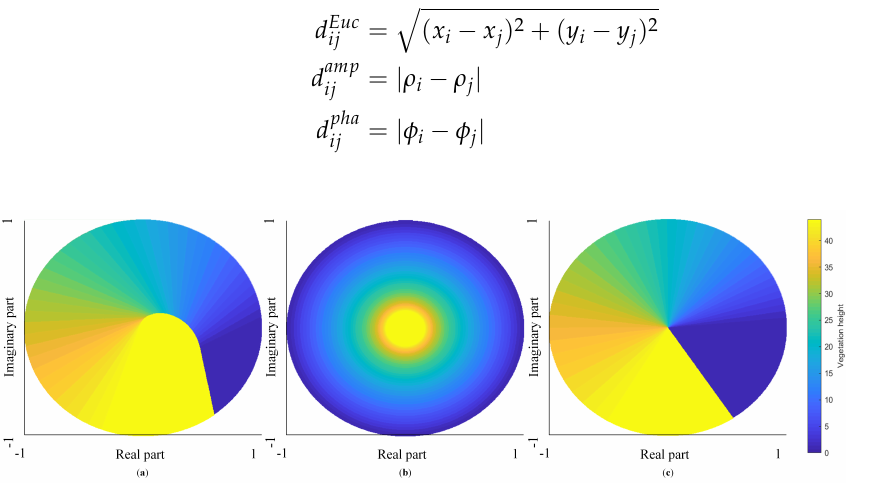
Figure 6. The mapping of vegetation height and coherence in the CUC plane using least distance criterion with ( a ) the Euclidean distance, ( b ) the amplitude distance and ( c ) the phase